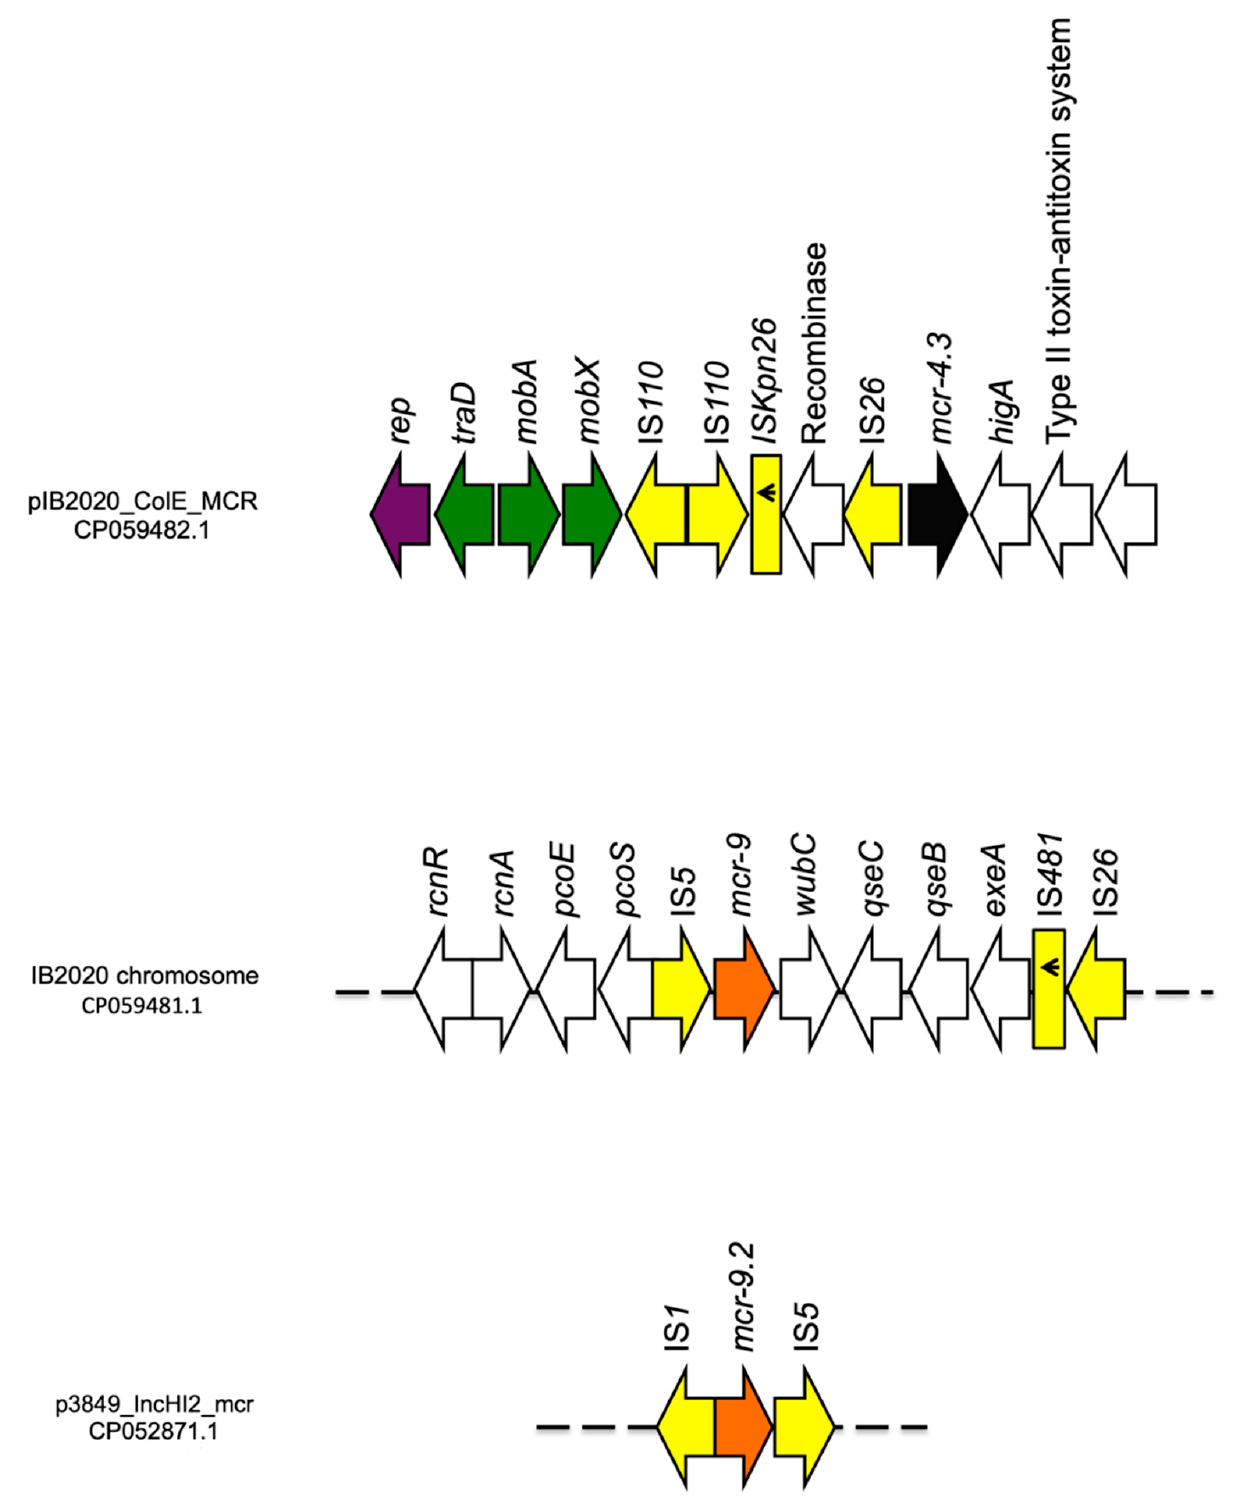
Figure 2. Linear map of the pIB2020_ColE_MCR, mcr-9 genetic environment of the IB2020 chromosome, and the genetic environment of mcr-9.2 harbored on p3849_IncHI2_mcr. Arrows show the direction of transcription of ORFs while rectangles represent truncated ORFs. Replication, mobile elements, mcr-4.3 , mcr-9 and mcr-9.2 , transfer/mobility and other remaining genes are designated by violet, yellow, black, orange, and white, respectively.